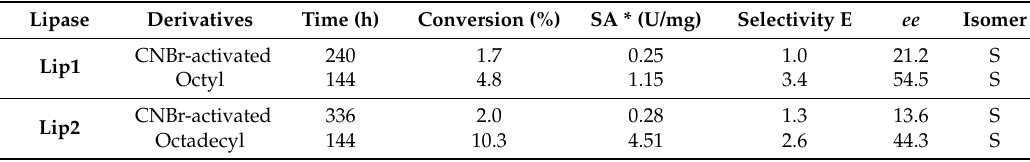
Table 8. 2- O -butyryl-2-phenylacetic hydrolysis by Lip1 and Lip2.